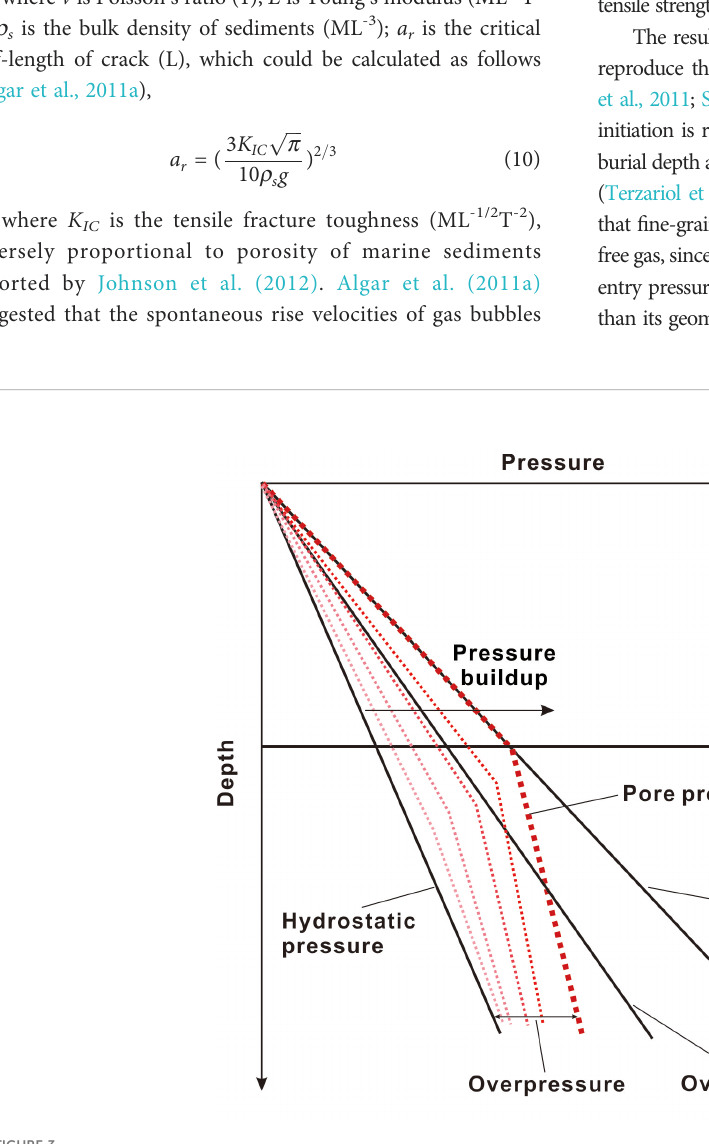
FIGURE 3 Illustration of pressure buildup in marine sediments [modi fi ed from Scandella et al. (2011)]. Sediments would be fractured if pore pressure reaches critical